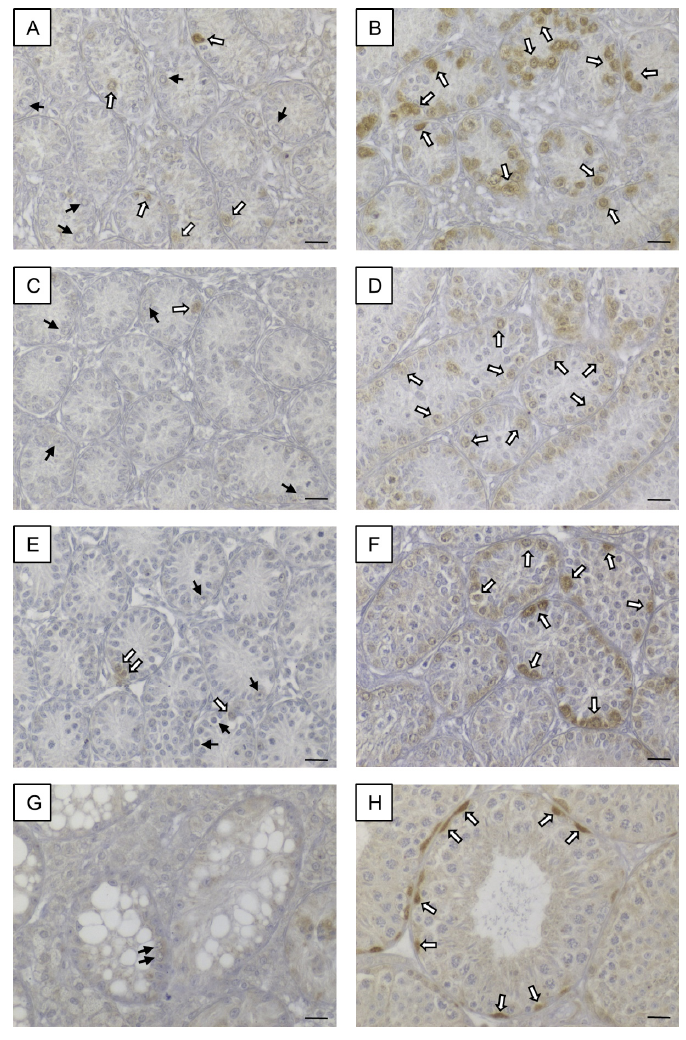
Figure 11. SOHLH1 immunohistochemistry. ( A ) Seminiferous tubules of 8-day-old SCCx43KO mice contained some immunopositive spermatogonia (white arrows) but also immunonegative spermatogonia (black arrows). ( B ) Strong immunosignal in almost all spermatogonia in seminiferous tubules of 8-day-old WT littermates (white arrows). ( C,E ) In seminiferous tubules of 10- and 12-day-old SCCx43KO animals, single immunopositive spermatogonia were observed (white arrows) but most spermatogonia showed no immunostaining (black arrows). ( D,F ) Distinct immunoreaction was found in spermatogonia of 10- and 12-day-old WT mice. ( G ) No immunosignal was observed in germ cells (black arrows) of adult SCCx43KO animals. ( H ) A spermatogonial subpopulation showed strong immunostaining (white arrows) in adult WT mice. KO: knockout, SCCx43KO: Sertoli cell-specific Cx43 knockout, WT: wild type, scale bars: 20 µ m, numerical aperture: